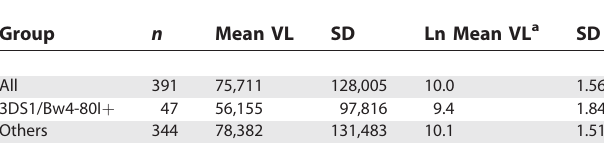
Table 2. Summary of Mean HIV-1 RNA Load among 391 Seroconverters during the First 3 y after Seroconversion